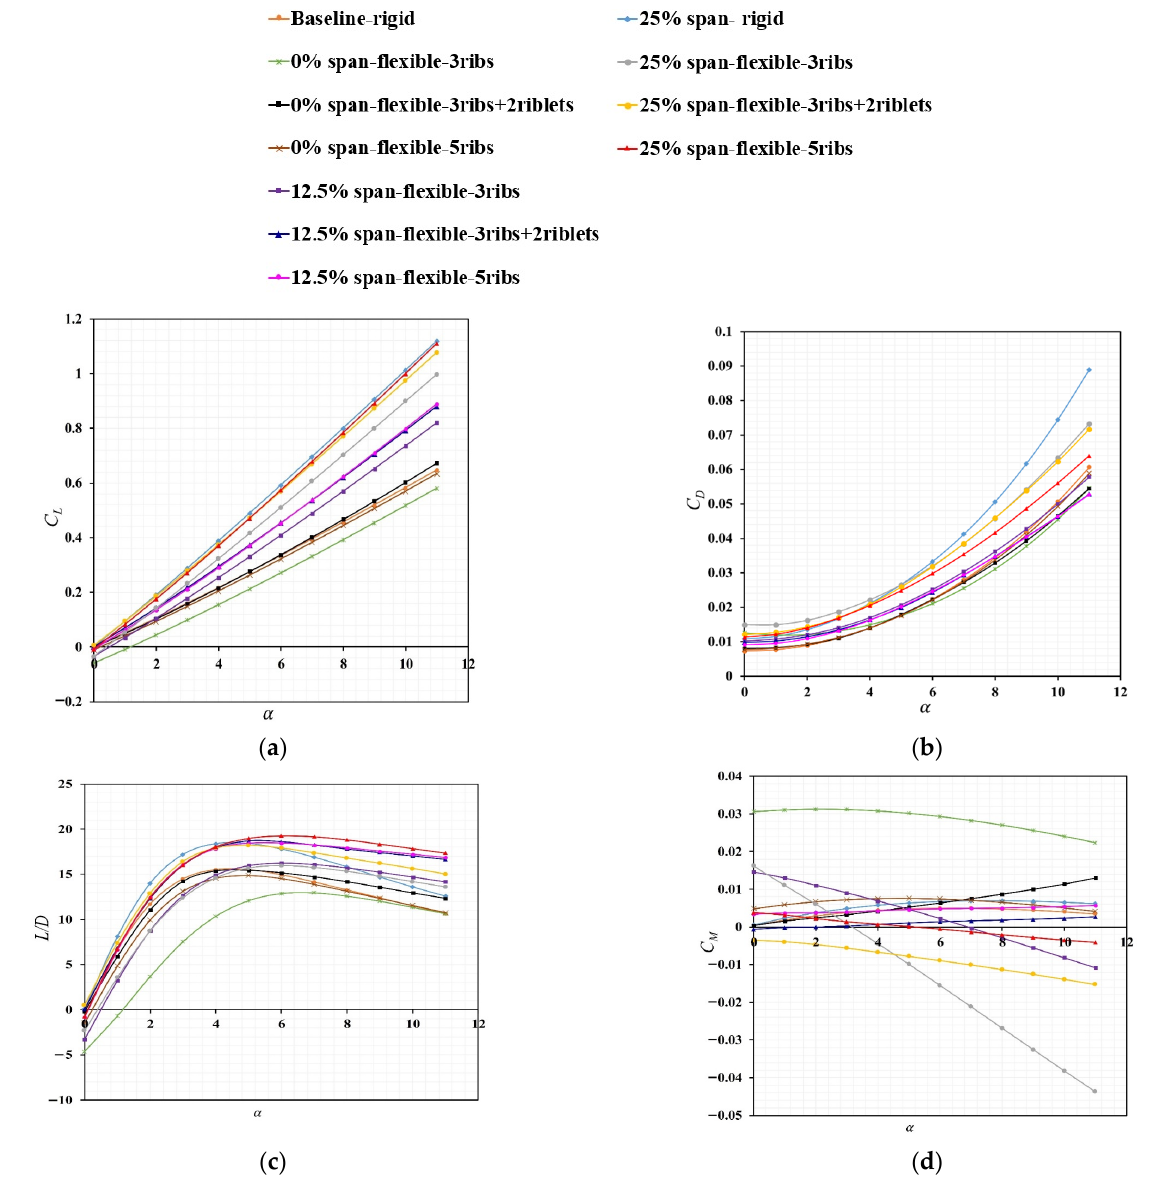
Figure 17. Variations of C L , C D , L/D , and C M with α : ( a ) C L vs. α . ( b ) C D vs. α . ( c ) L/D vs. α . ( d ) C M vs. α .